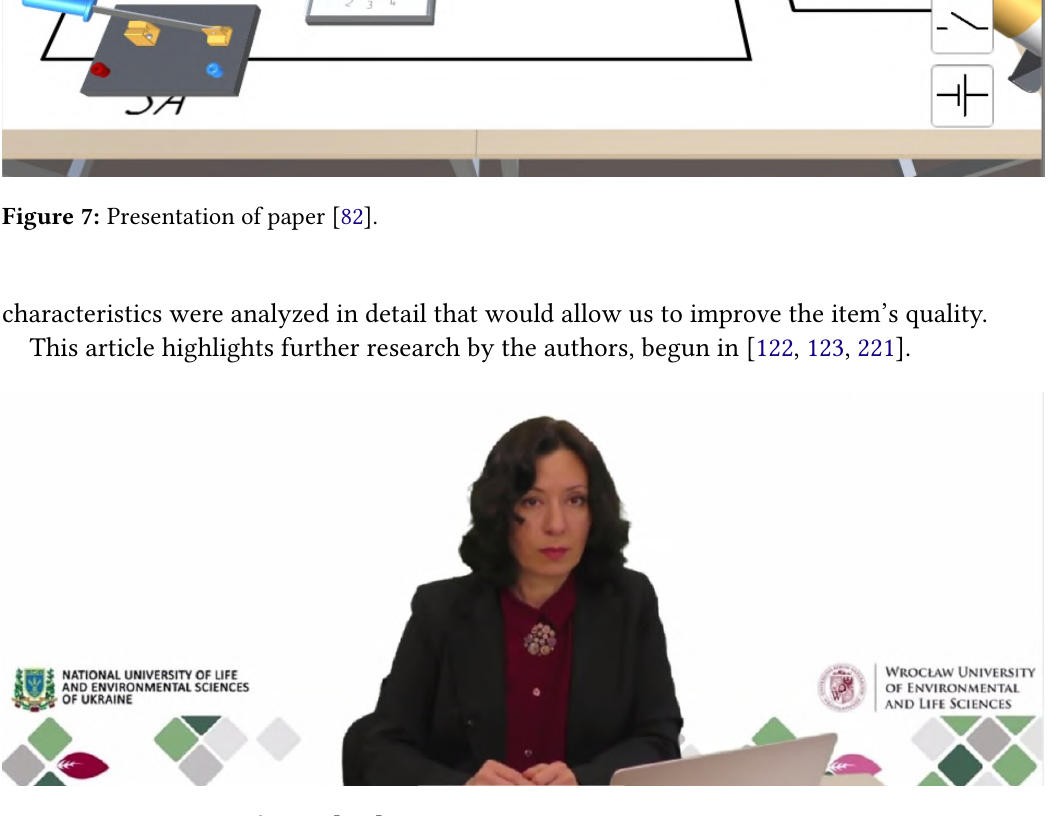
Figure 8: Presentation of paper